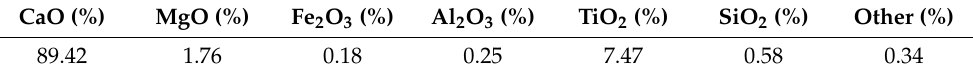
Table 2. Main chemical composition of fly ash. Table 3. Main chemical composition of lime.